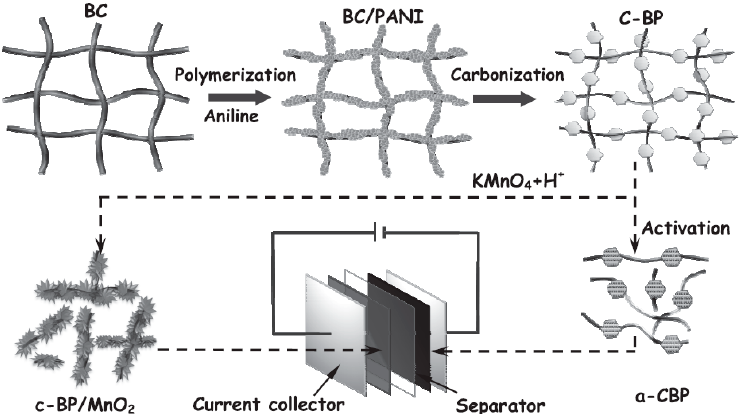
Figure 3. Schematic illustration for the fabrication of the electrode material application in an asymmetric supercapacitor device using bacterial cellulose (BC) as a template and precursor. Reprinted with permission from [54], copyright 2014, Wiley-VCH.